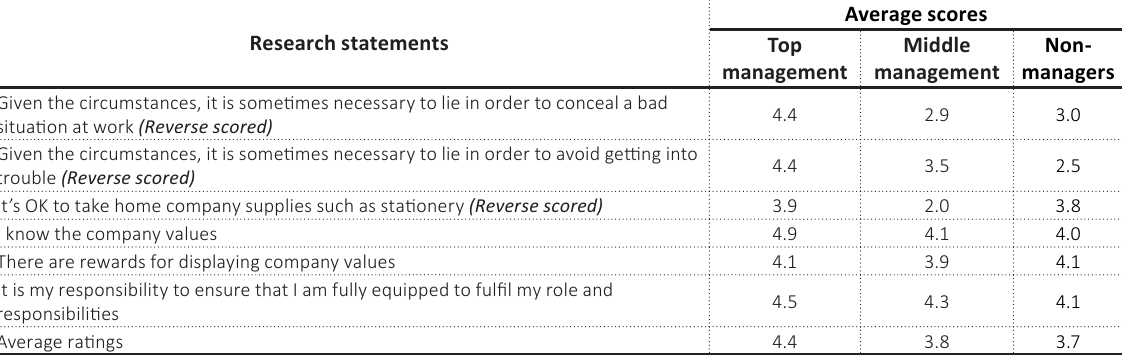
Table 2 (cont.). Perception of the level of ethics